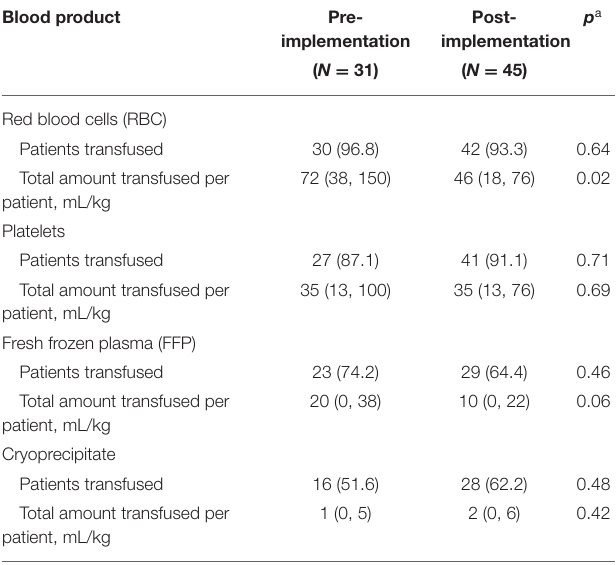
TABLE 5 | Blood product transfusions pre- and